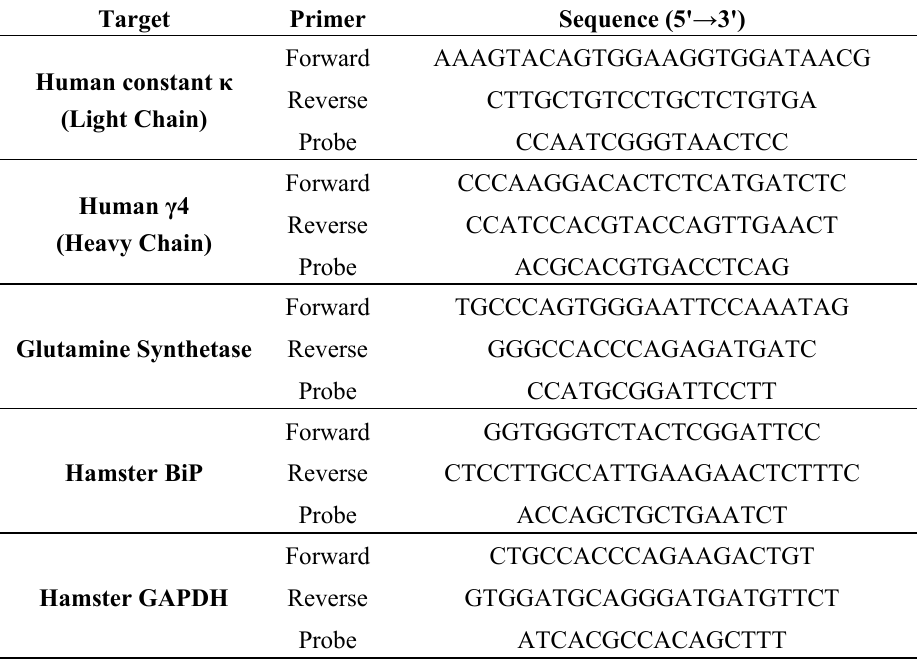
Table 4. TaqMan primer/probe sequences used in qPCR